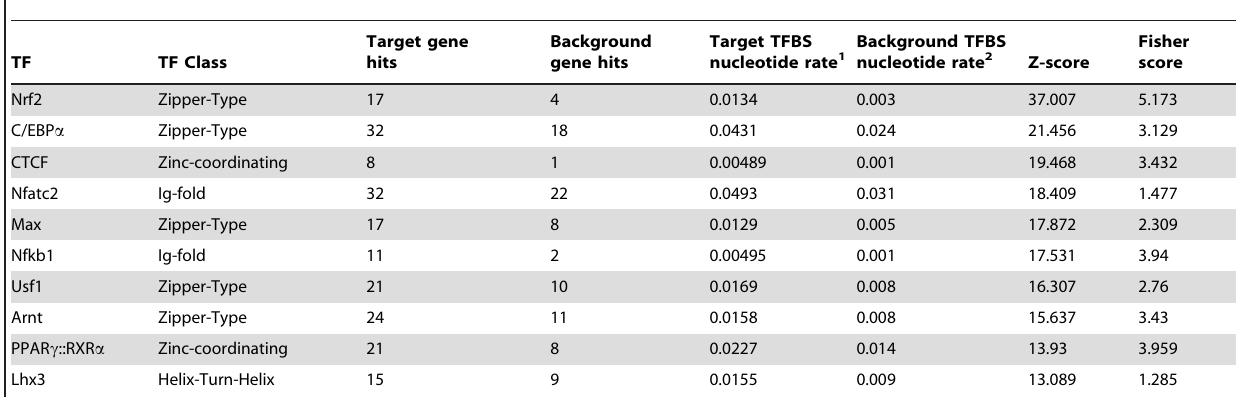
Table 2. Putative binding sites of transcription factors in drug processing genes induced by Nrf2 using the oPOSSUM system.